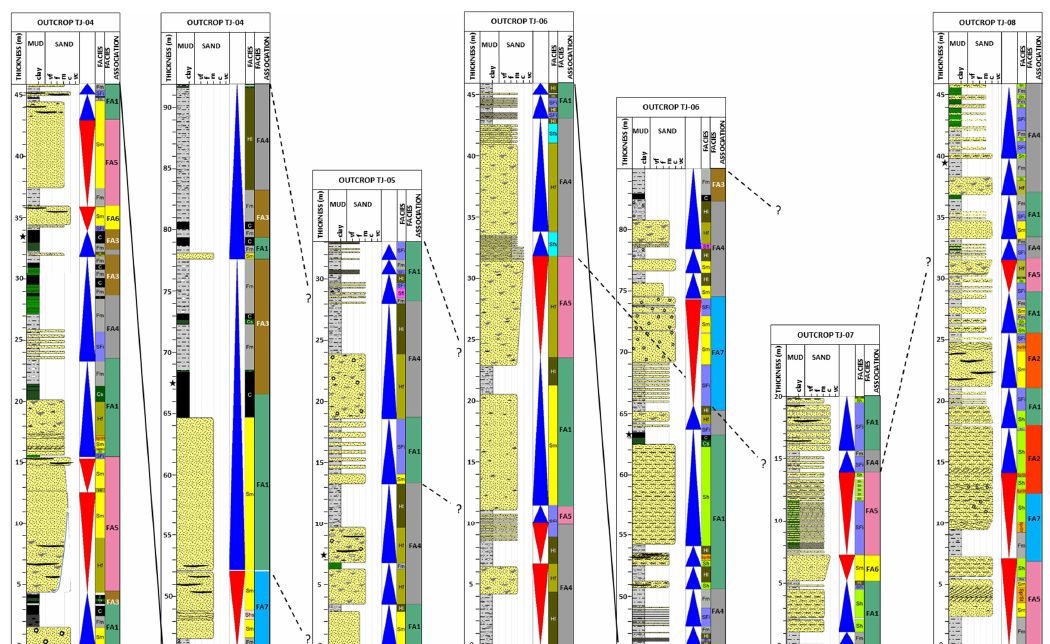
Figure 4. Sedimentary log successions with lithofacies, trace fossils, and facies association information in the studied outcrops of the Unit II Tanjong Formation.